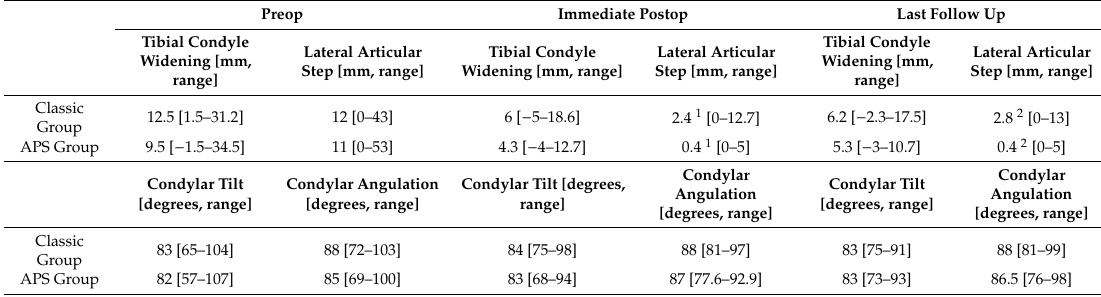
Table 2. Fracture displacement parameters before surgery, after open reduction and after fracture healing respectively (at last follow up) for both